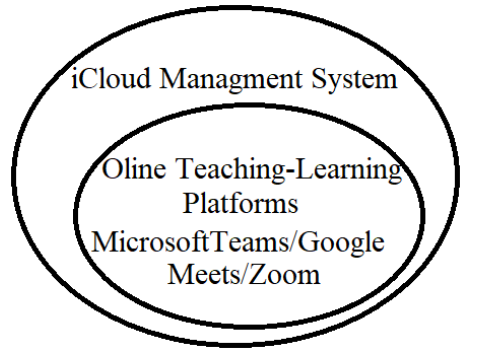
Figure 4. Software tools for Online learning